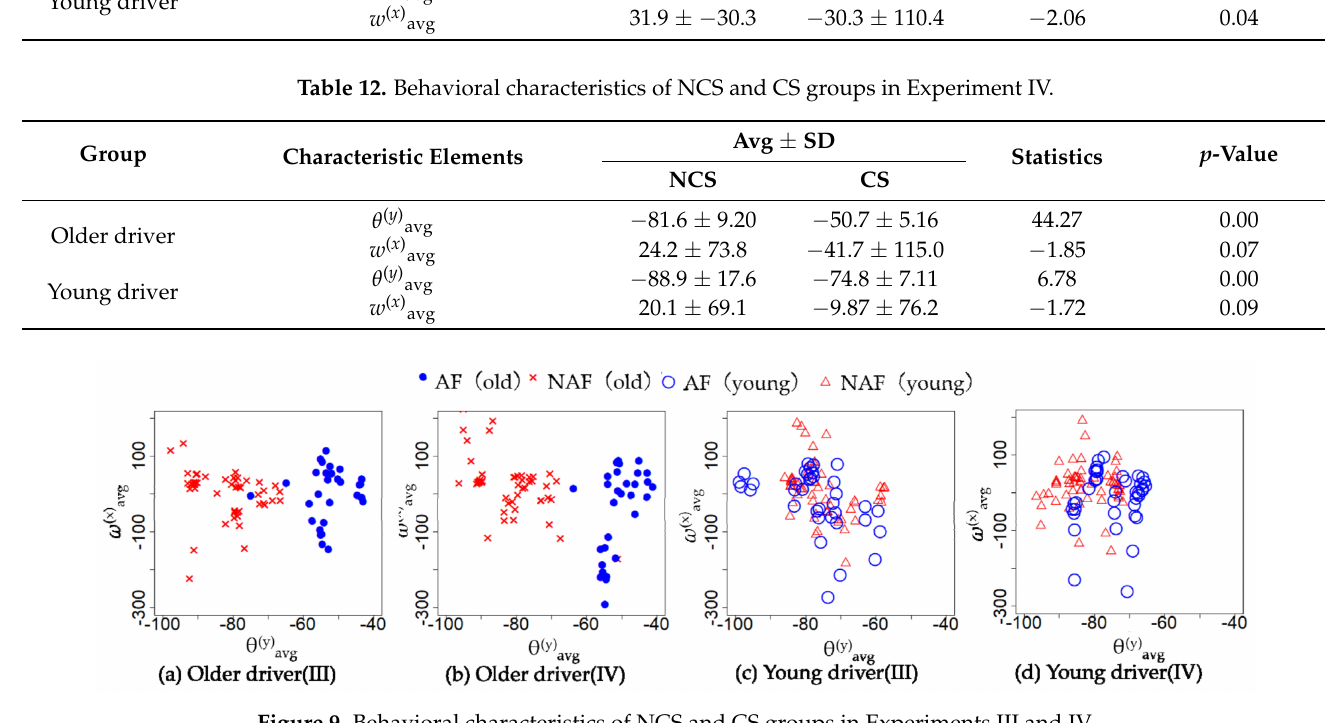
Figure 9. Behavioral characteristics of NCS and CS groups in Experiments III and IV.